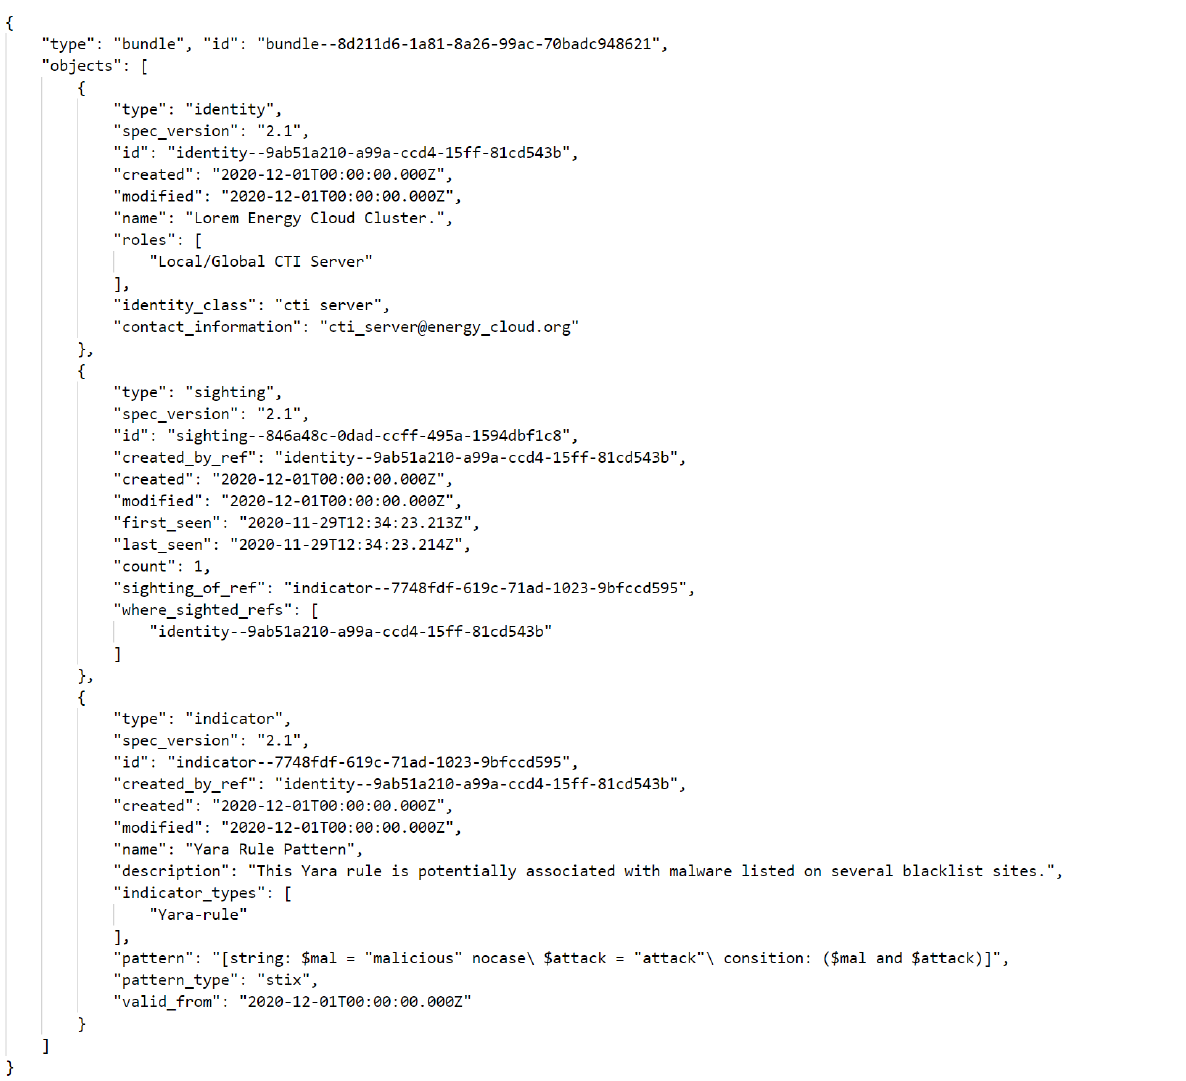
Figure 5. Example of STIX-based CTI security